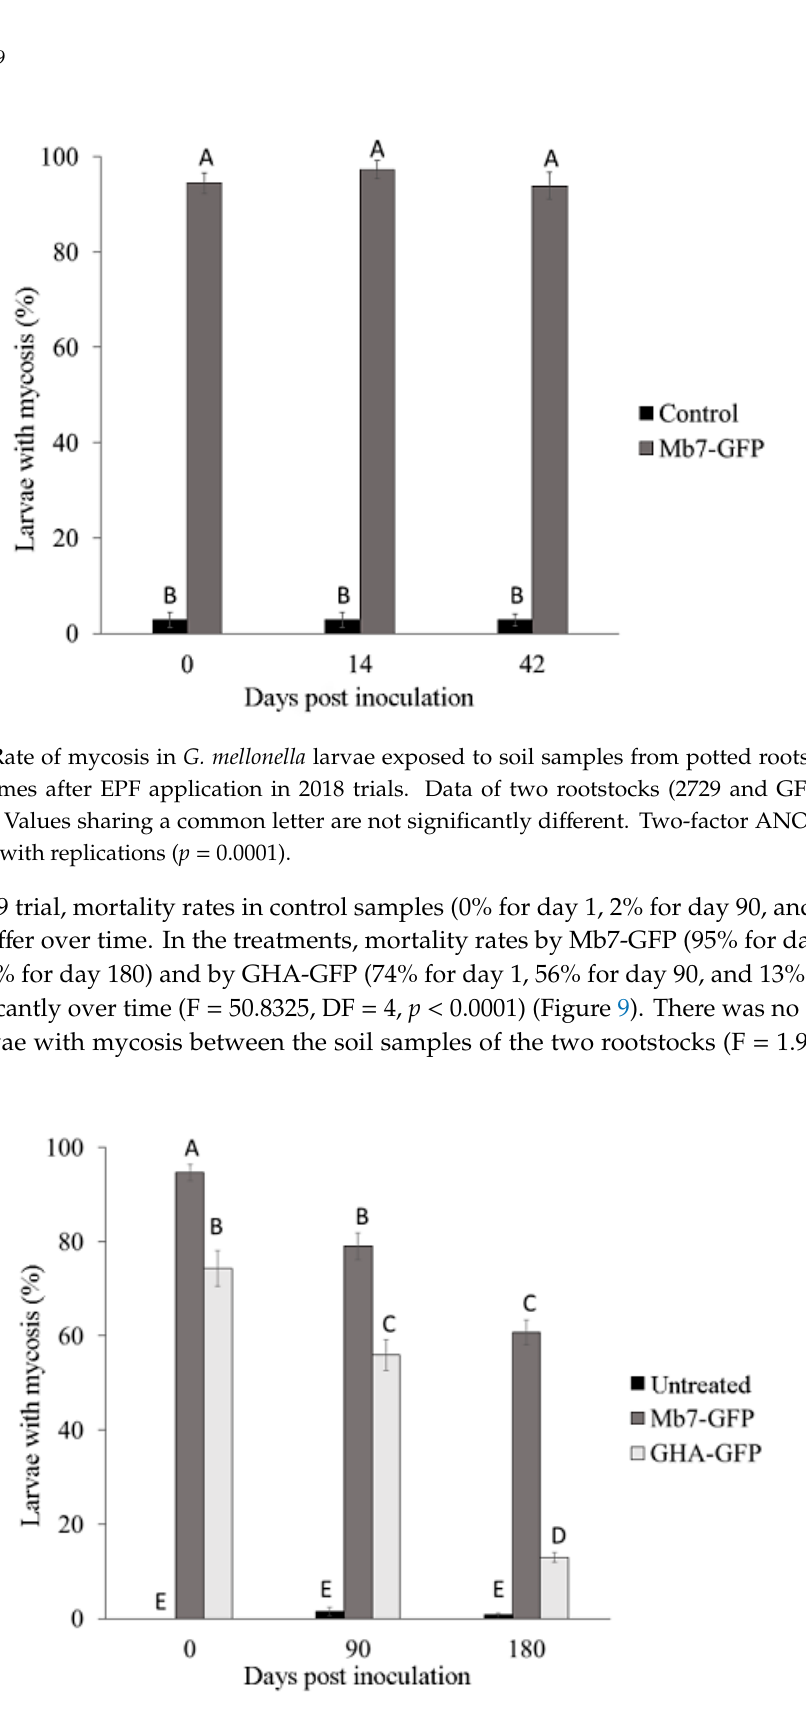
Figure 9. Rate of mycosis in G. mellonella larvae exposed to soil samples from potted rootstocks at different times after planting in 2019. Data of two rootstocks (2729 and GF677) are combined. Values sharing a common letter are not significantly different. Two-factor ANOVA was performed with replications ( p = 0.0001).